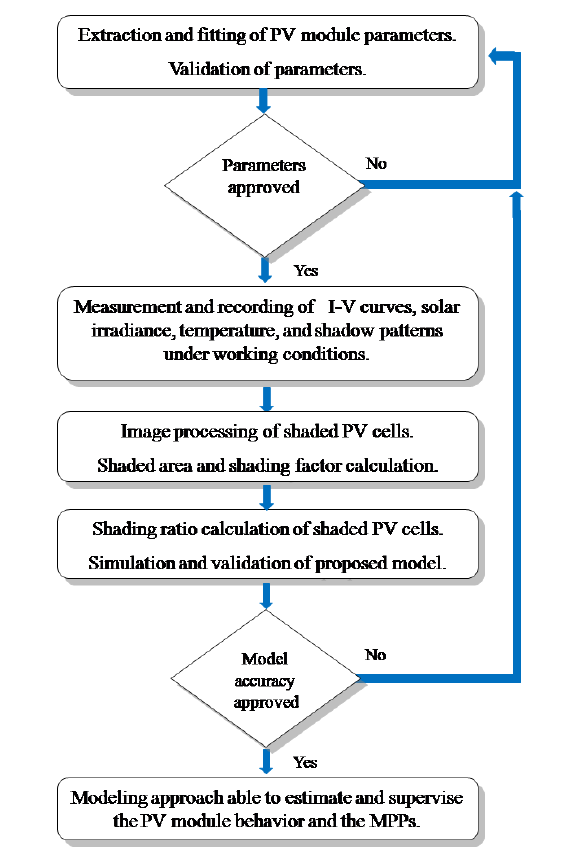
Figure 1. Modeling methodology using the shading ratio and image